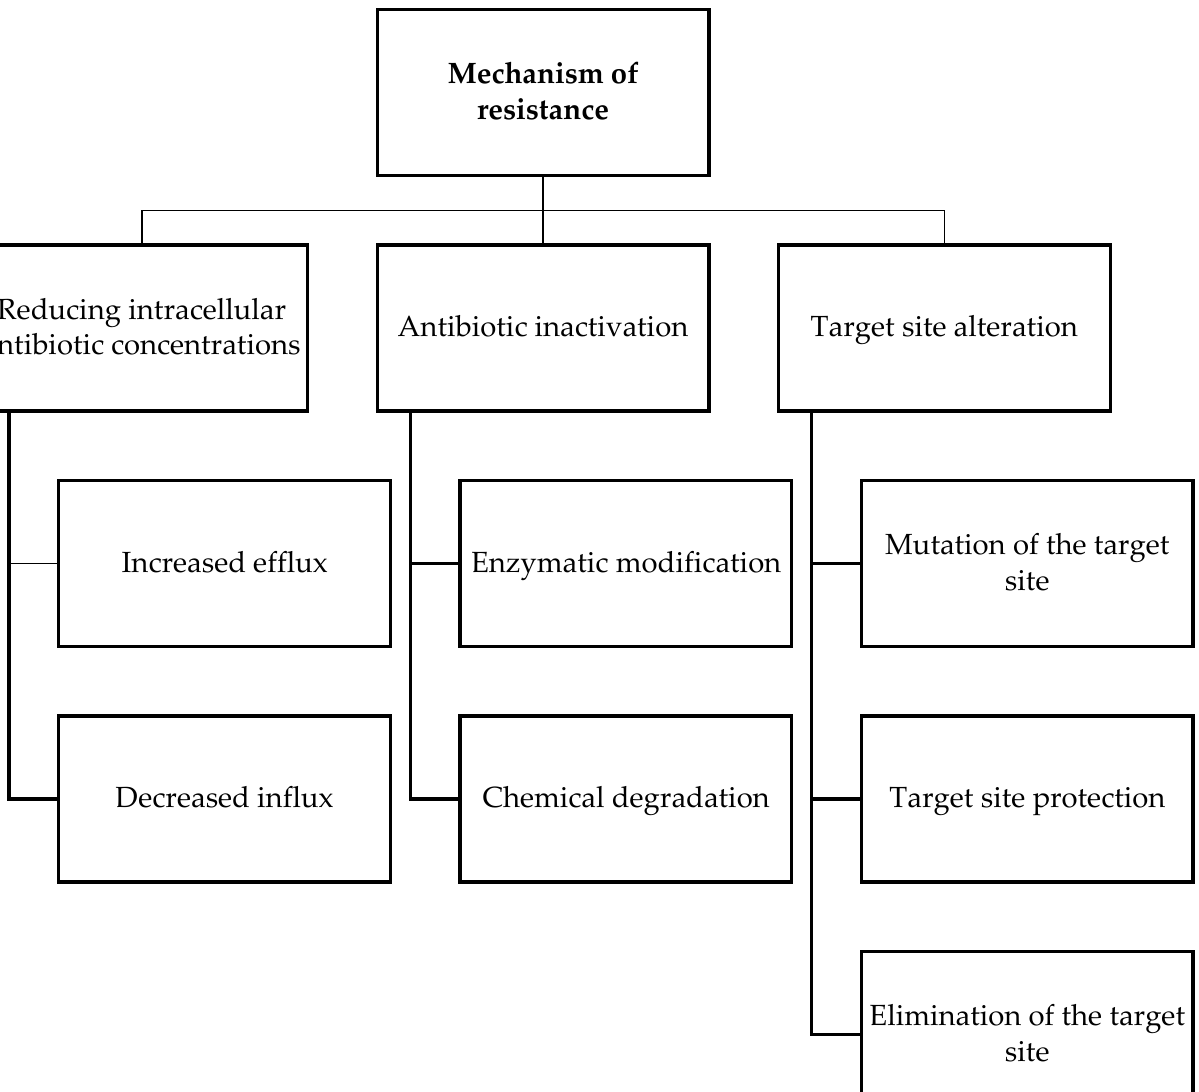
Figure 7. Mechanism of antimicrobial resistance which include reduce intracellular antibiotic concentration, antibiotic inactivation, and target site alteration.